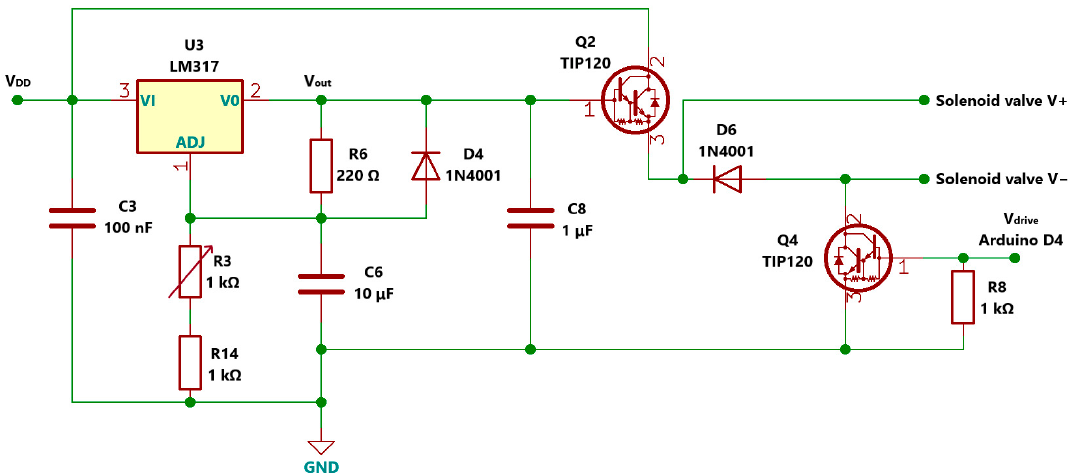
Figure 4. Solenoid valve power supply and control circuit operated by Arduino digital pin D4.